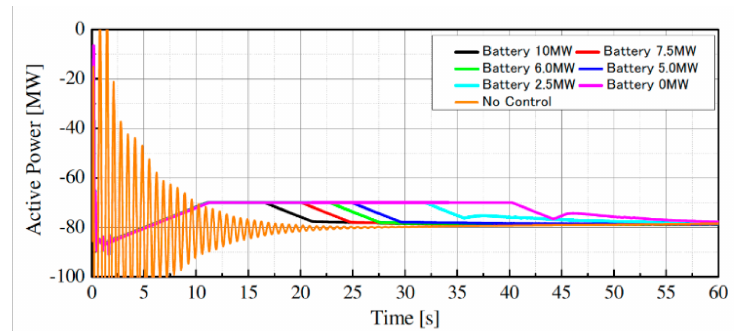
Figure 23. ASG and FSG output (II) (Pumping Operation).